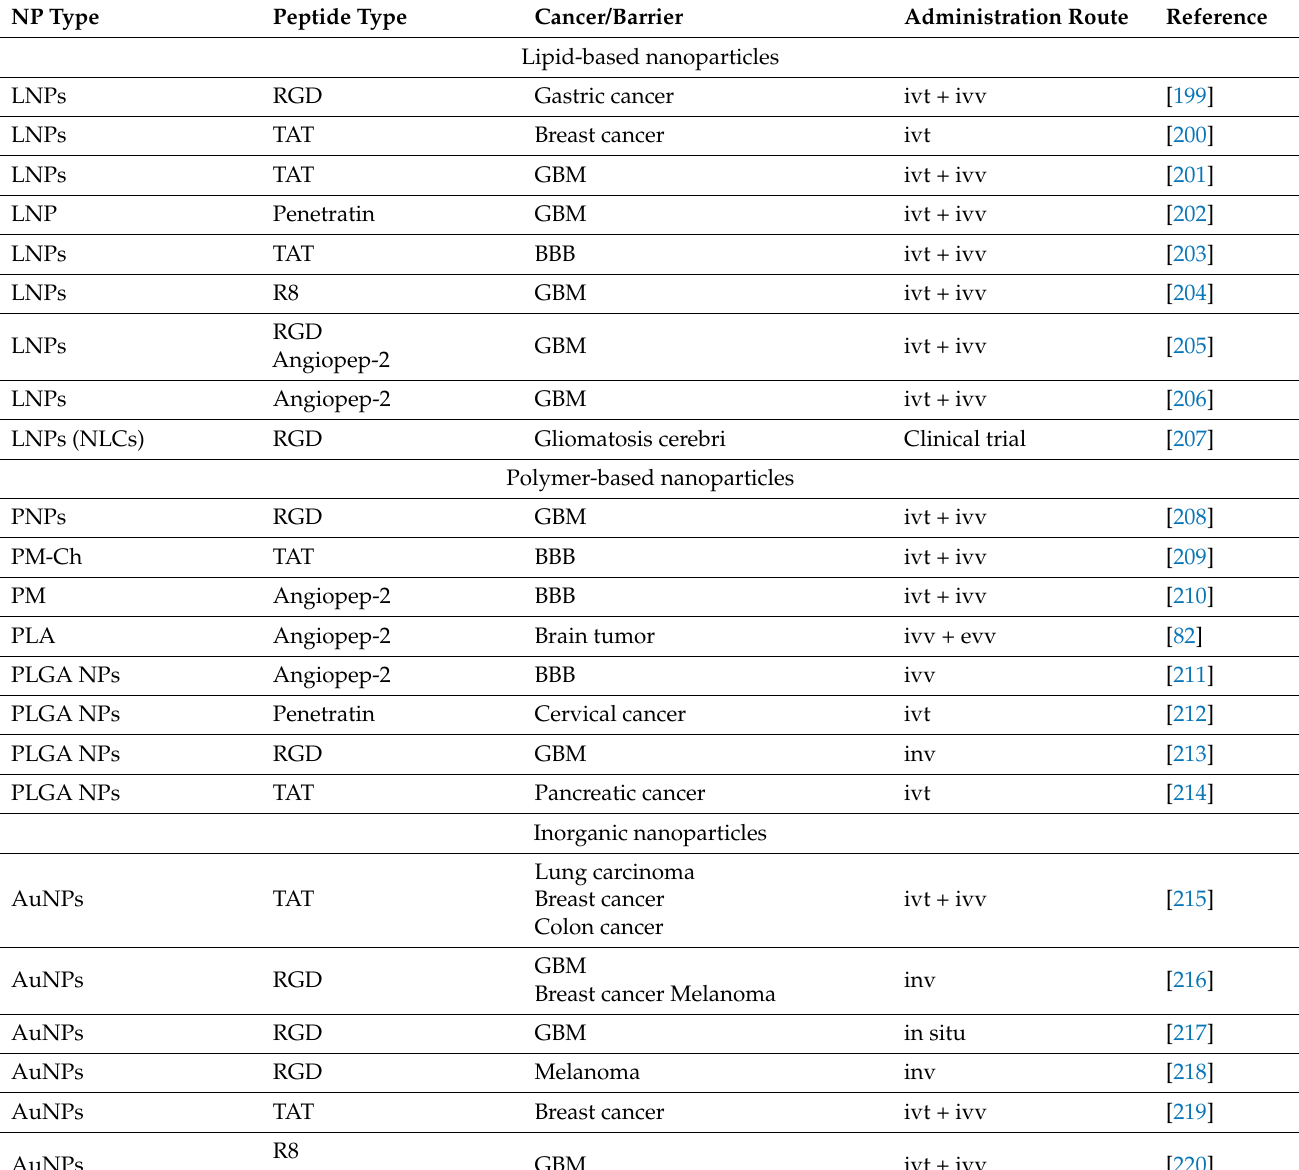
Table 2. CPP-functionalized NPs for tumor